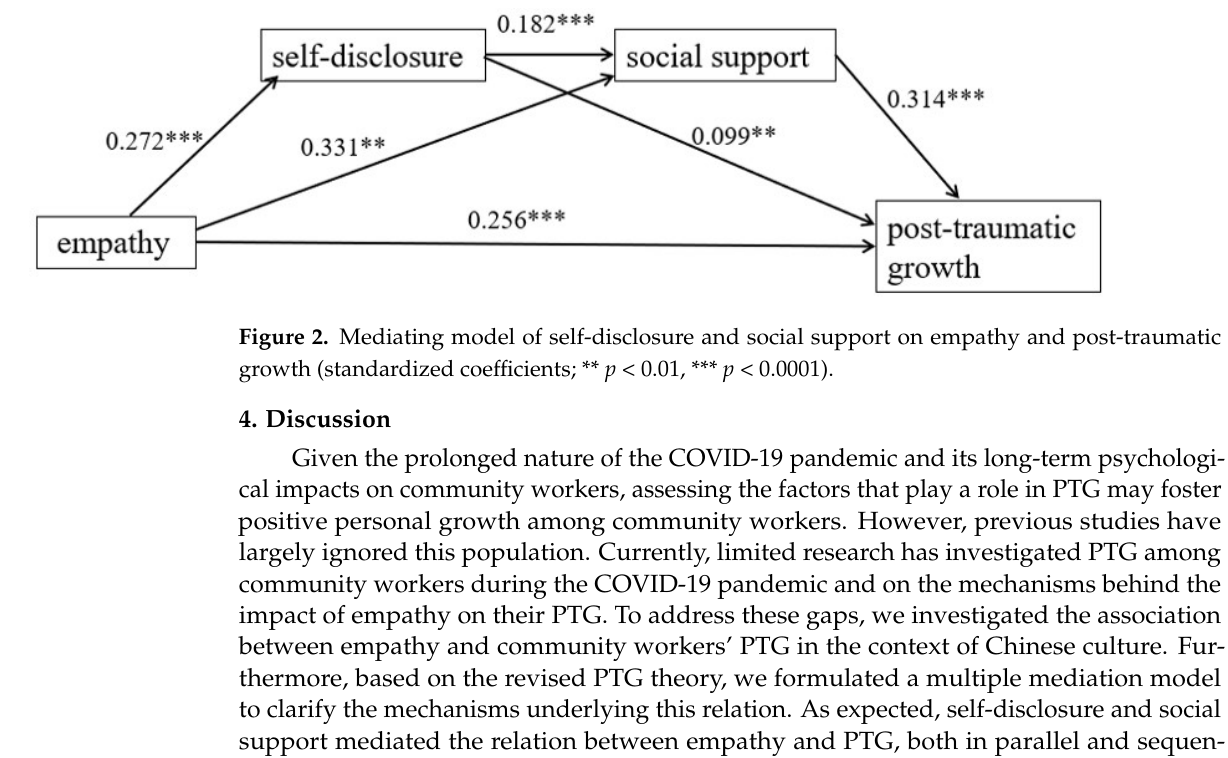
8 of 13 Table 3. Regression analysis of the relationship between variables. ( N = 414). Outcome Variable